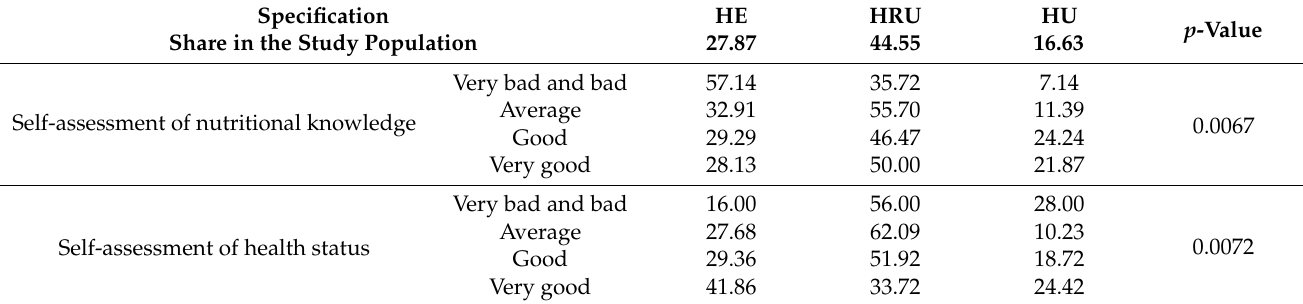
Table 7. Clusters characteristics by nutritional knowledge and health status (n = 487, data in %).